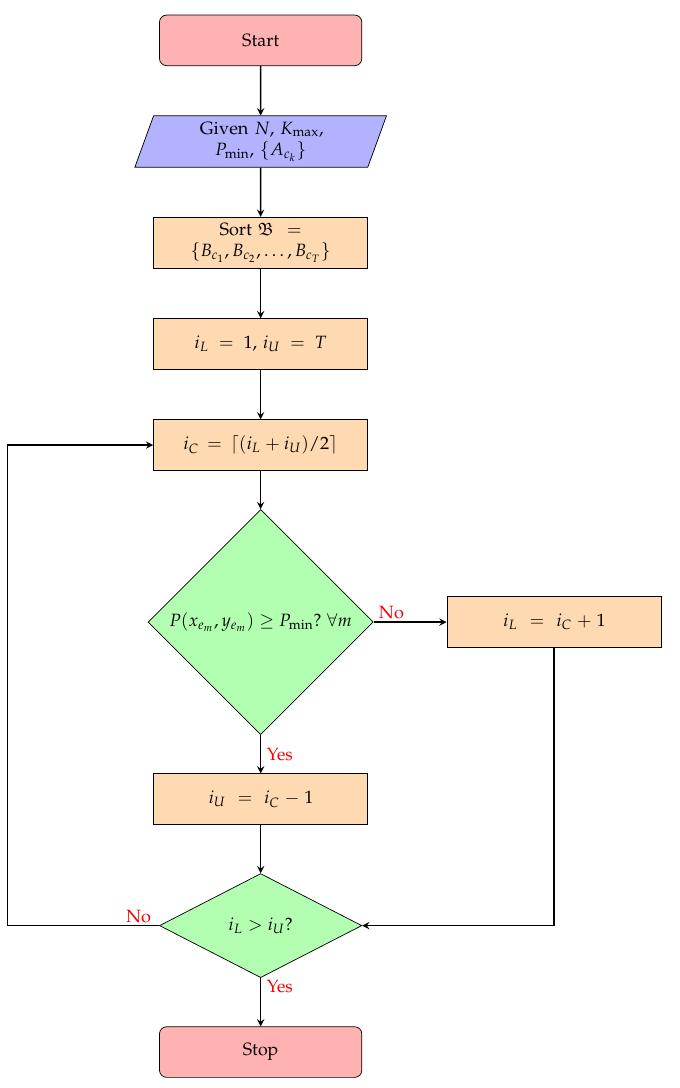
Figure 2. Flowchart of the binary-search based cell positioning (BSCP)